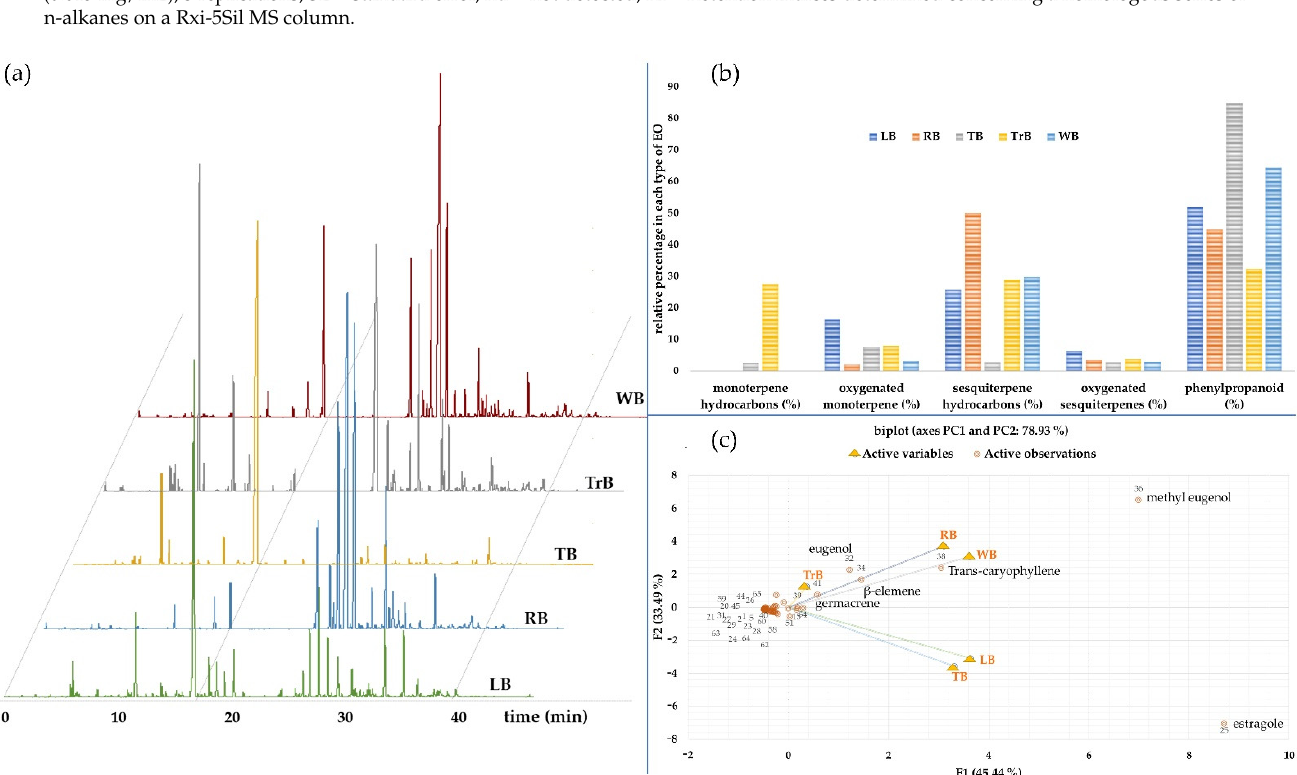
Figure 1. The chromatograms of the VOC profiles of different basils essential oils (LB; lemon basil ( O. citriodorum ), RB; red holy basil ( O. sanctum var. Rama), TB; Thai basil ( O. basilicum var. thyrsiflorum), TrB; tree basil ( O. gratissimum ), and WB; white holy basil ( O. sanctum var. Shyama)) with the detailed analysis of the chemical compositions as illustrated in Table 2 ( a ), their relative percentage composition of volatile types ( b ), and a biplot diagram illustrating the relationships among the volatiles components with five basil types ( c ). Table 2. Chemical compositions of the essential oils from five Ocimum spp. plants.